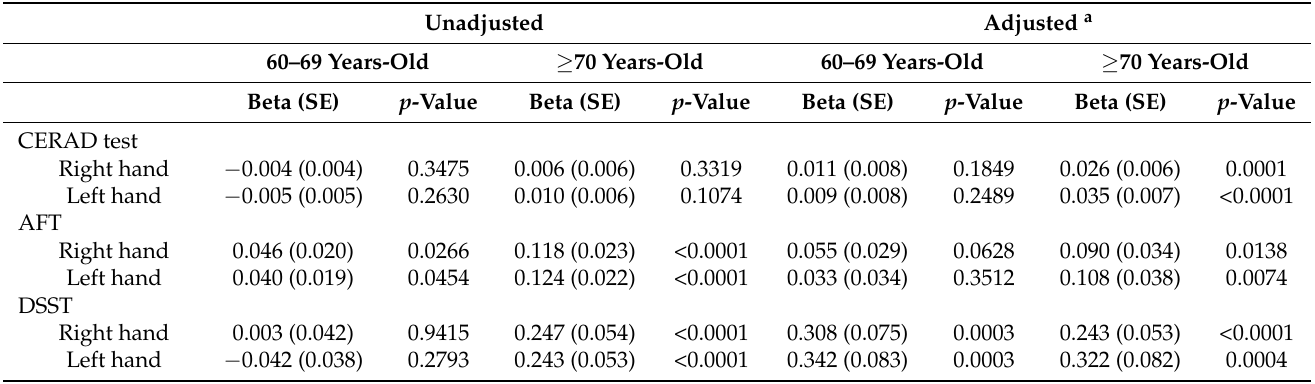
Table 3. Beta coefficients (SE) for HGS in age groups by cognitive function test.